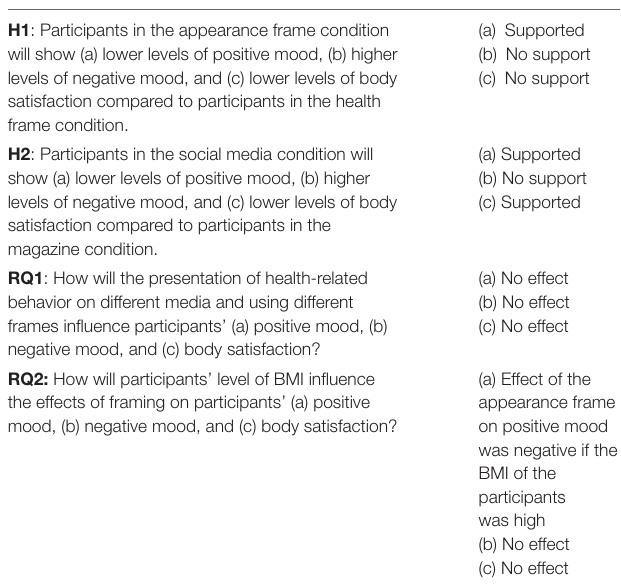
TABLE 4 | Overview of the assumptions and